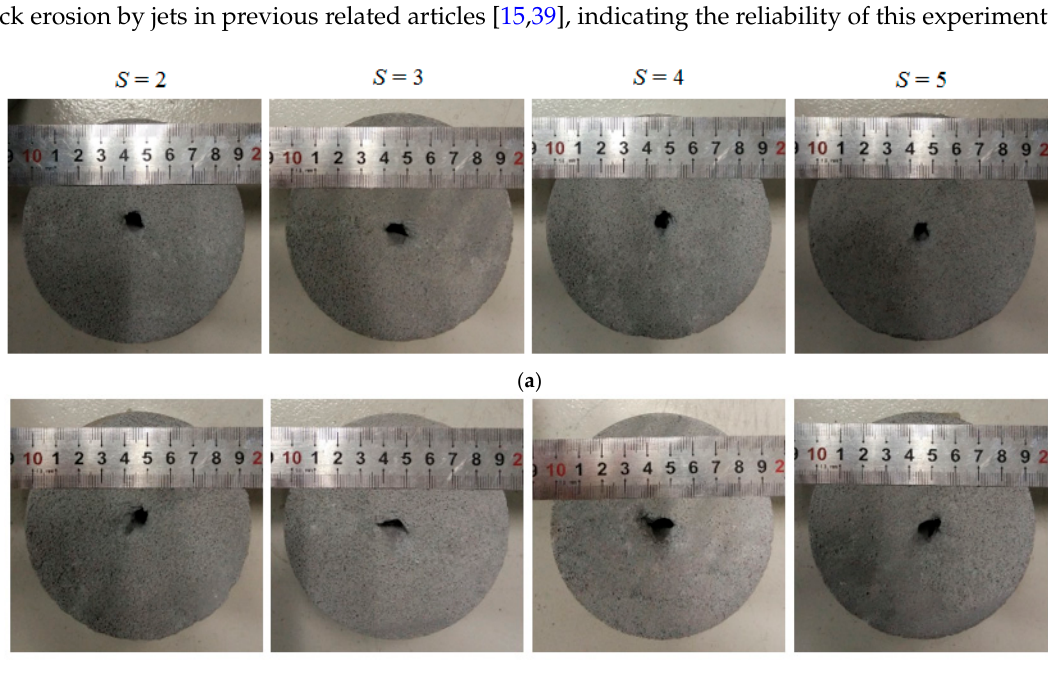
Figure 5. Cont. Figure 5.